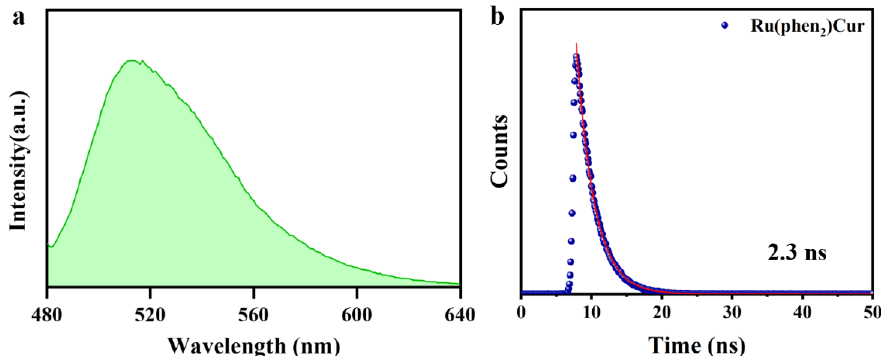
Figure 2. Characterizations of Ru(II)-coumarin complexes. ( a ) Fluorescence spectra of Ru(II)-coumarin complexes with the λ ex = 450 nm. ( b ) Fluorescence lifetime of Ru(II)-coumarin complexes. Selective labelling of cell membrane can reduce the interference of background fluo- rescence. When the dynamic assembly and disassembly of RuCM NP was confirmed, the feasibility of turn-on fluorescence imaging in lipophilic phase was further investigated.